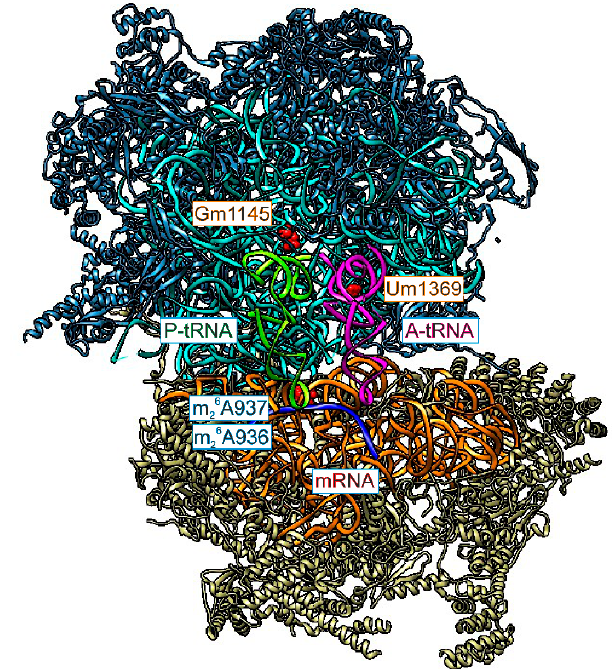
Figure 2. Location of the universally conserved methylated nucleotides, shown as red spacefilled objects and marked, in the mammalian mitochondrial rRNA relative to the ligands of the ribosome [69]. A slice through the top-viewed functional complex is shown. mRNA is shown as blue ribbon, A-site bound tRNA is shown as pink ribbon and P-site bound tRNA is shown as green ribbon. UCSF Chimera [36] was used to create this illustration.